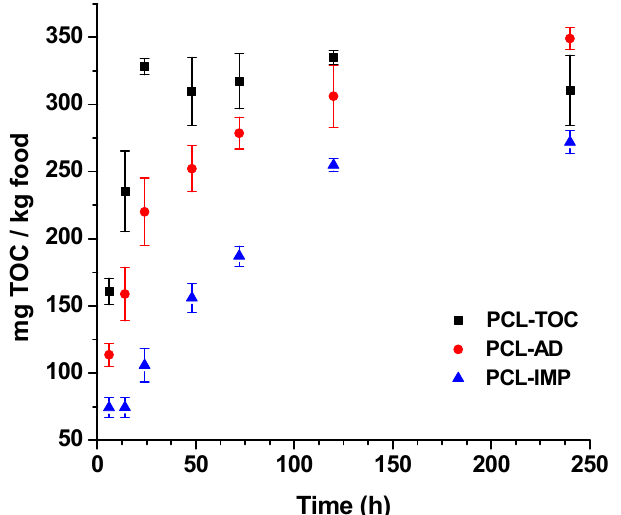
Figure 3. Release of α -tocopherol from PCL-TOC, PCL-AD and PCL-IMP films into ethanol 50% (v/v) over 10 days (mg per kg of food).